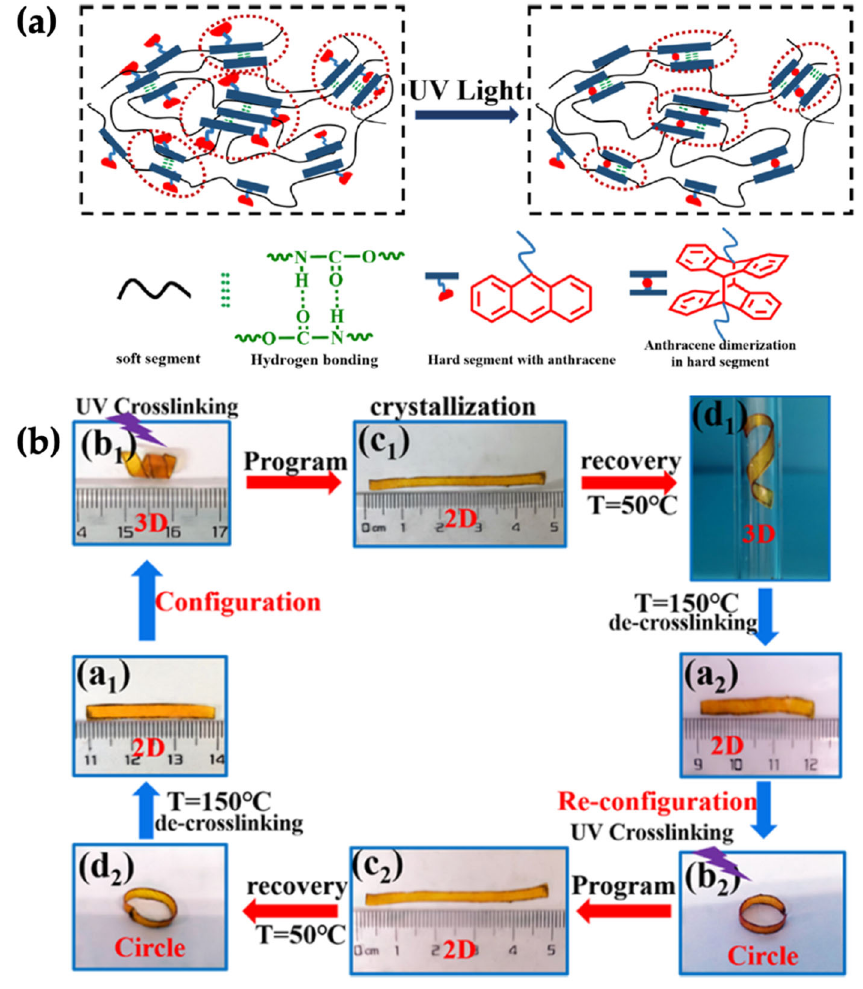
Figure 11. Shape memory thermoplastic polyurethane (TPU) with the photodimerisation of anthracene (AN); ( a ) model of the network structure of AN–TPU networks, and ( b ) shape memory behaviour of AN–TPU samples; ( a1 ) is an original shape, ( b1 ) is configurated to helix shape using UV irradiation, ( c1 ) is fixed to linear shape by crystallization and recovered to helix shape ( d1 ) under 50 °C, ( a2 ) is de ‐ crosslinking sample under 150 °C, ( b2 ) is re ‐ configurated to circle shape using UV irradiation, and ( c2 ) is fixed to linear shape by crystallization and recovered to circle shape ( d2 ) under 50 °C [47]. Adapted with permission from [47]. Copyright 2021 American Chemical Society.